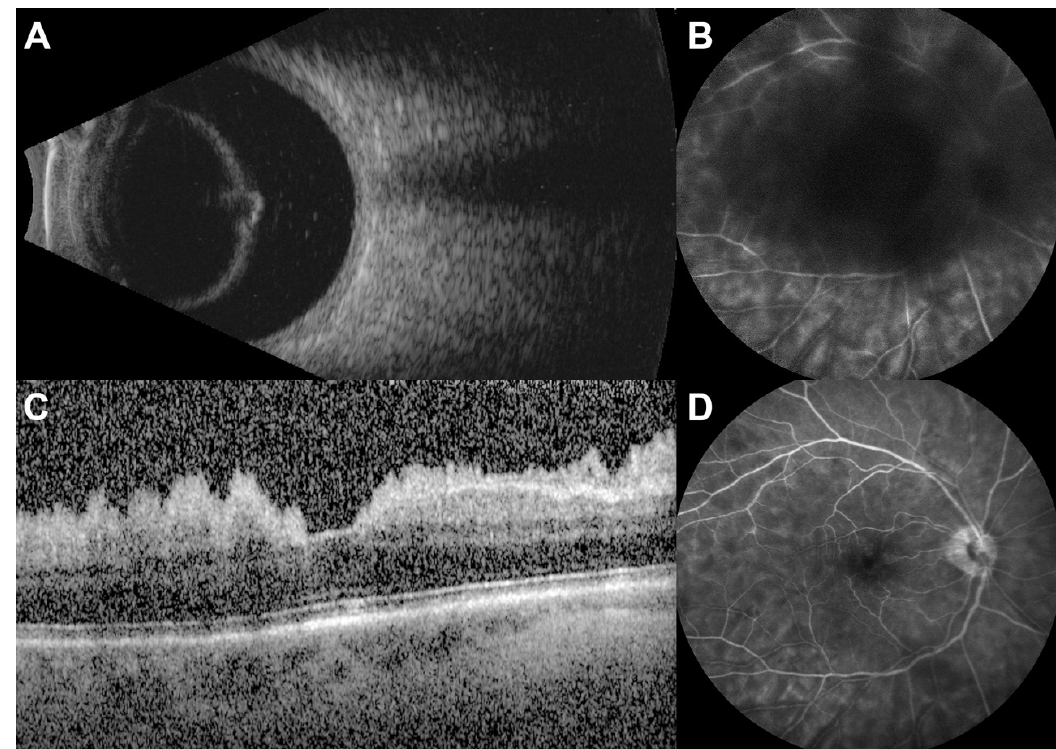
Figure 1. ( A ) . B-scan ultrasound of the right eye showing a posterior vitreous detachment with delineation of the posterior hyaloid face and vitritis caused by metastatic cells. ( B ) . Late-phase intravenous fluorescein angiogram of the right eye demonstrating blockage from the overlying vitritis. There is diffuse, patchy hyperfluorescence with areas of hyperfluorescence along the venous arcades suggestive of mild retinal vasculitis. ( C ) . Ocular coherence tomography (OCT) of the right macula obtained nine days after diagnostic vitrectomy demonstrating a sawtooth pattern of metastatic cells on the pre-retinal surface. ( D ) . Late-phase intravenous fluorescein angiogram of the right eye obtained nine days after diagnostic vitrectomy. There is diffuse, patchy hyperfluorescence, optic nerve staining, and mild angiographic macular edema. There is hypofluorescence adjacent to the retinal arteries and areas of venous hyperfluorescence seen best along the superior-temporal arcade that are suggestive of mild retinal vasculitis.